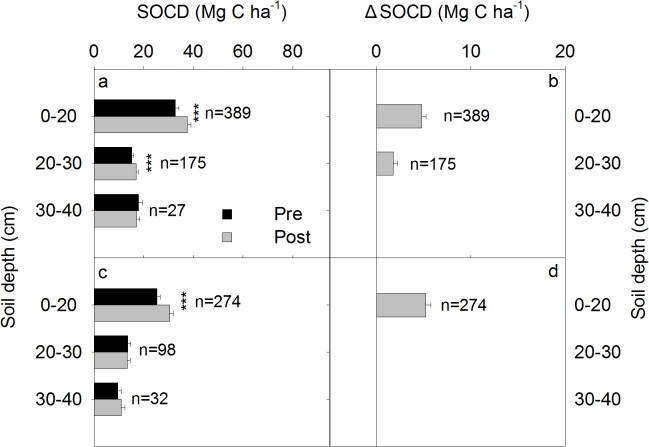
Profile distribution of SOCD and ΔSOCD in the 0‒40 cm layer of the soil for extensive utilization + cropland abandonment (a, b) and grazing exclusion + artificial plantation (c, d).The error bar represents the standard error. **and * represent the significance of the t-test for the paired sample at the 0.01 and 0.05 levels, respectively.